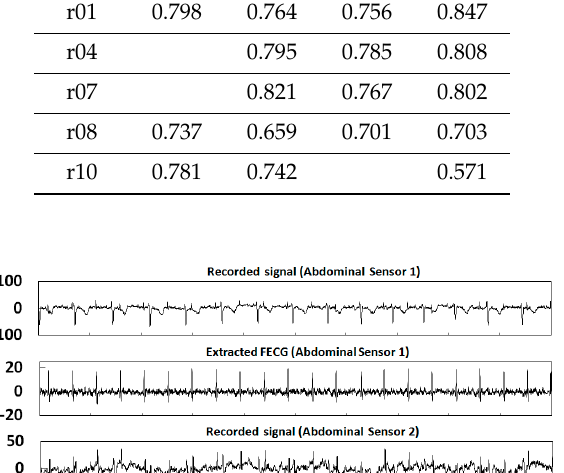
Figure 13. Extraction results for r04 in the ADFECGDB database.